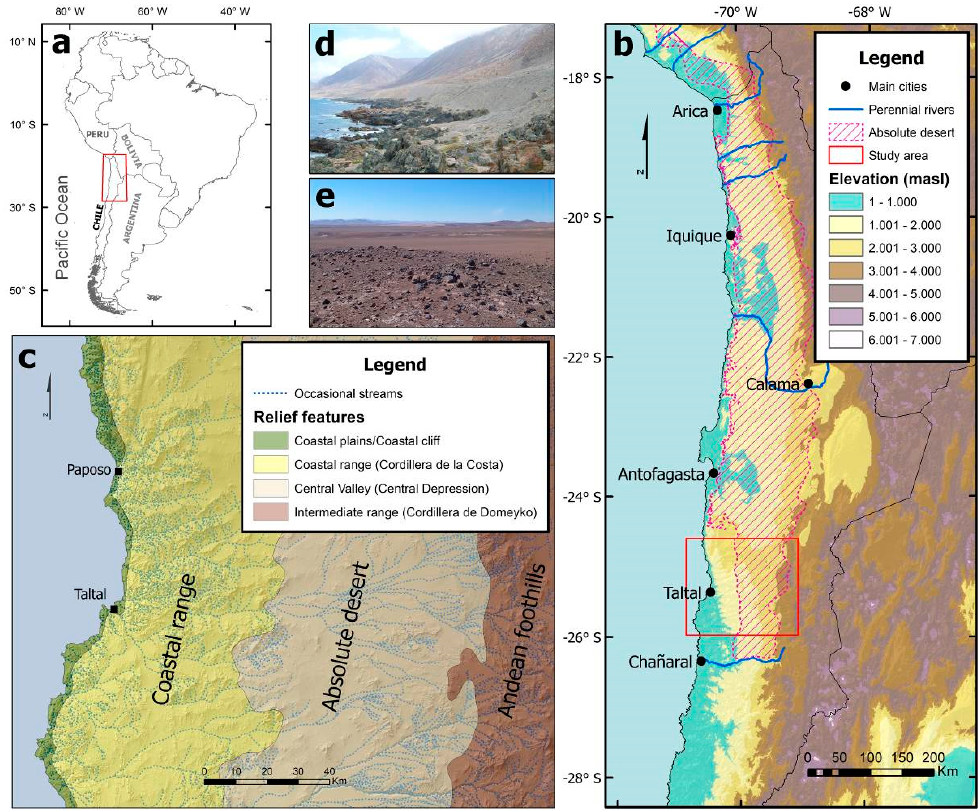
Figure 1. ( a ) Map of South America, red box indicates the extent of ( b ) altitudinal map showing the location of the absolute desert in northern Chile (hatched polygon), main cities (black dots), and perennial streams (blue lines). Red box in ( b ) corresponds to the map of study area ( c ) with the main topographic features and occasional streams (dashed blue lines); ( d ) panoramic view of the coastal platform and cliffs; ( e ) panoramic view of the absolute desert of Taltal. The main relief features correspond to, from west to east, a narrow litoral platform, a steep coastal range (Cordillera de la Costa), a longitudinal central valley or Central Depression, the foothills of the Andes (represented in the area by the Cordillera de Domeyko) and, finally, the higher-level Andes and the Altiplano [64].